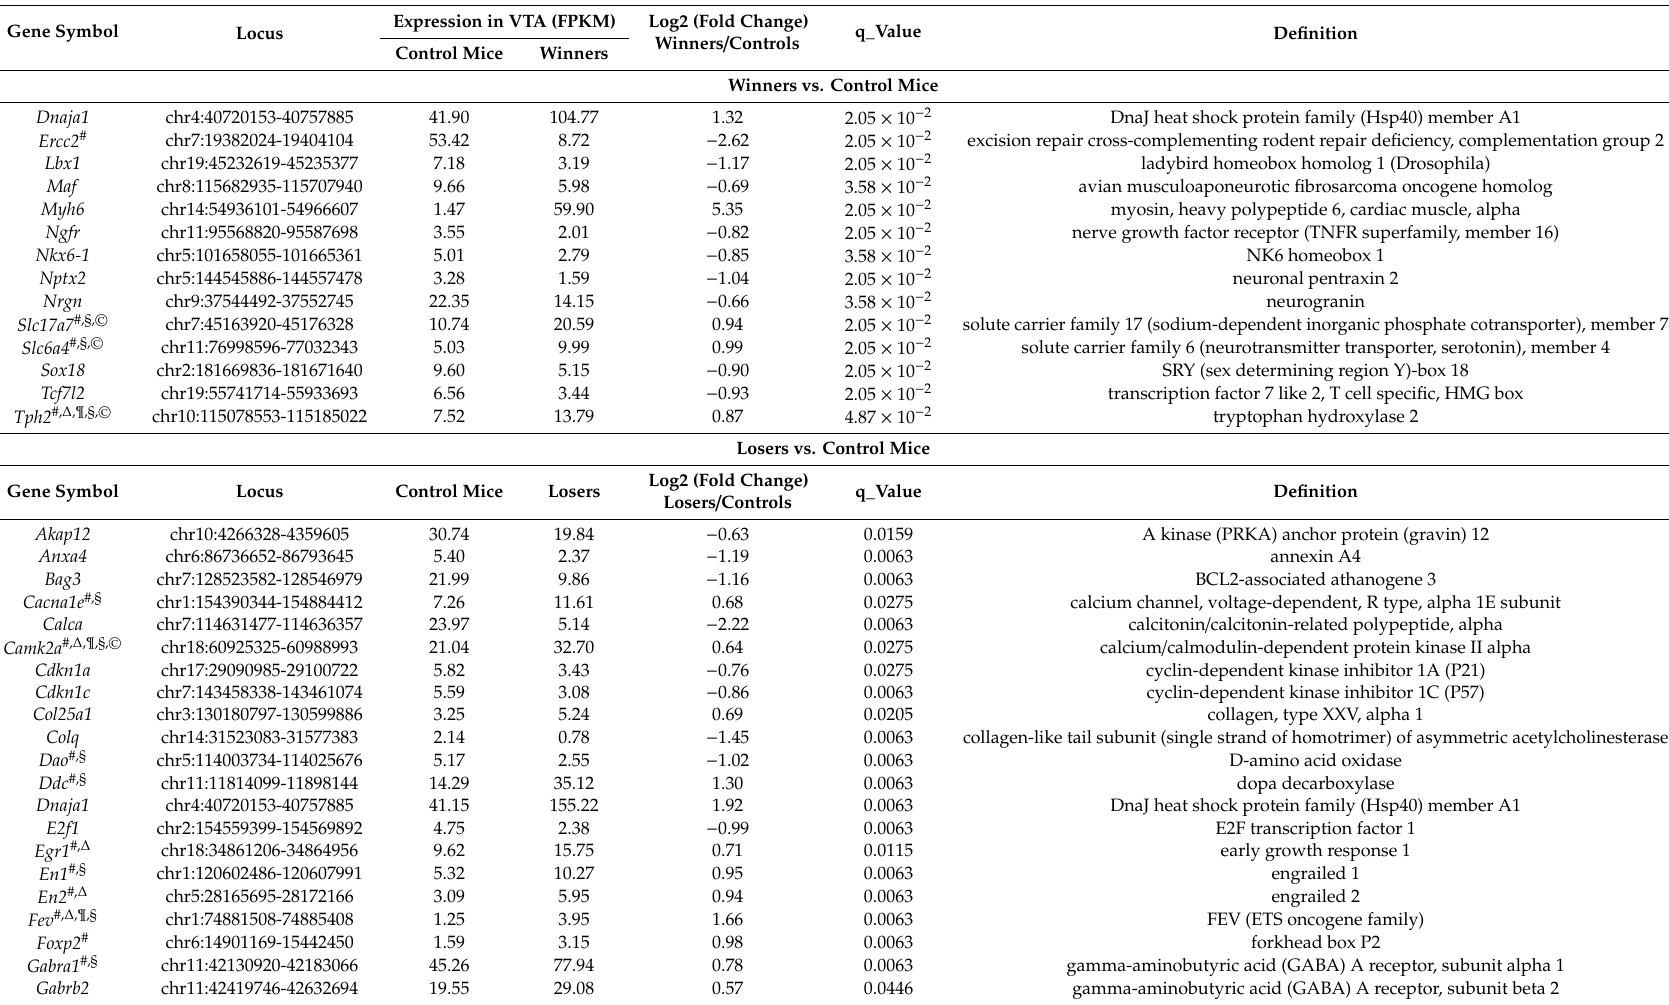
Table 1. Di ff erentially Expressed Genes (DEGs) associated with the behavior / neurological